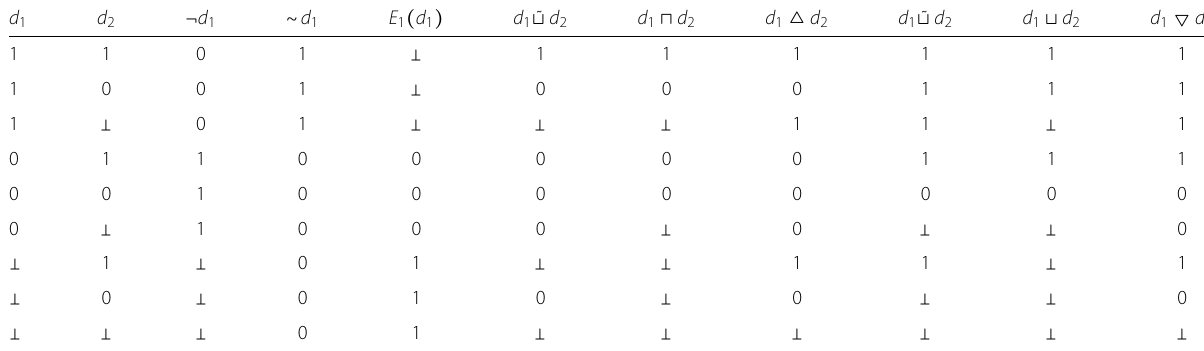
Table 1 Operators on the set D 3 = { 1,0, (cid:6)} d 1 d